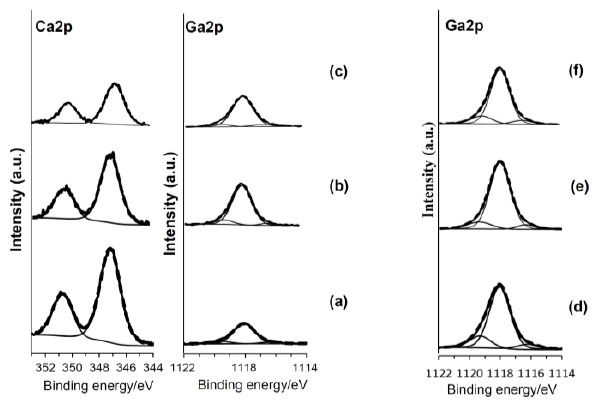
Figure 3. XPS profiles of Ca2p and Ga2p on Ti subjected to ( a ) 100Ca + 0.05Ga; ( b ) subsequent heat, and ( c ) final water treatment, or ( d ) 100Ga; ( e ) subsequent heat, and ( f ) final water treatment. Thick line represents spectrum. Thin lines represent deconvolution lines. Dot line represents composite line.